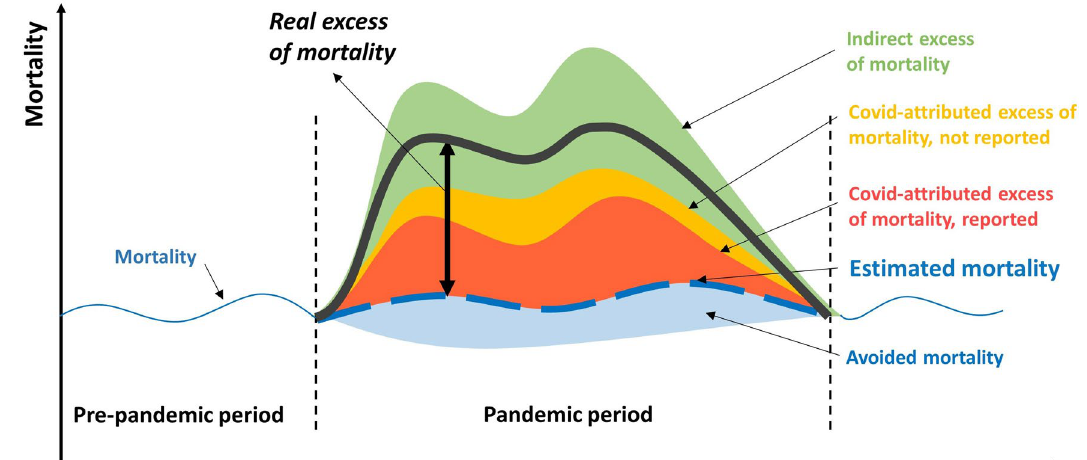
Figure 3. Theoretical representation of components of excess mortality in the COVID-19 pandemic. Excess mortality due to COVID-19 results in the addition of both direct (reported and not reported COVID-attributed deaths) and indirect mortality (due to the indirect effects of the pandemic on the health care system and on people’s behaviour), and the subtraction of avoided deaths (due to social